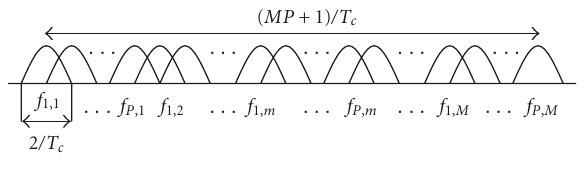
Figure 2: Spectrum of the transmitted